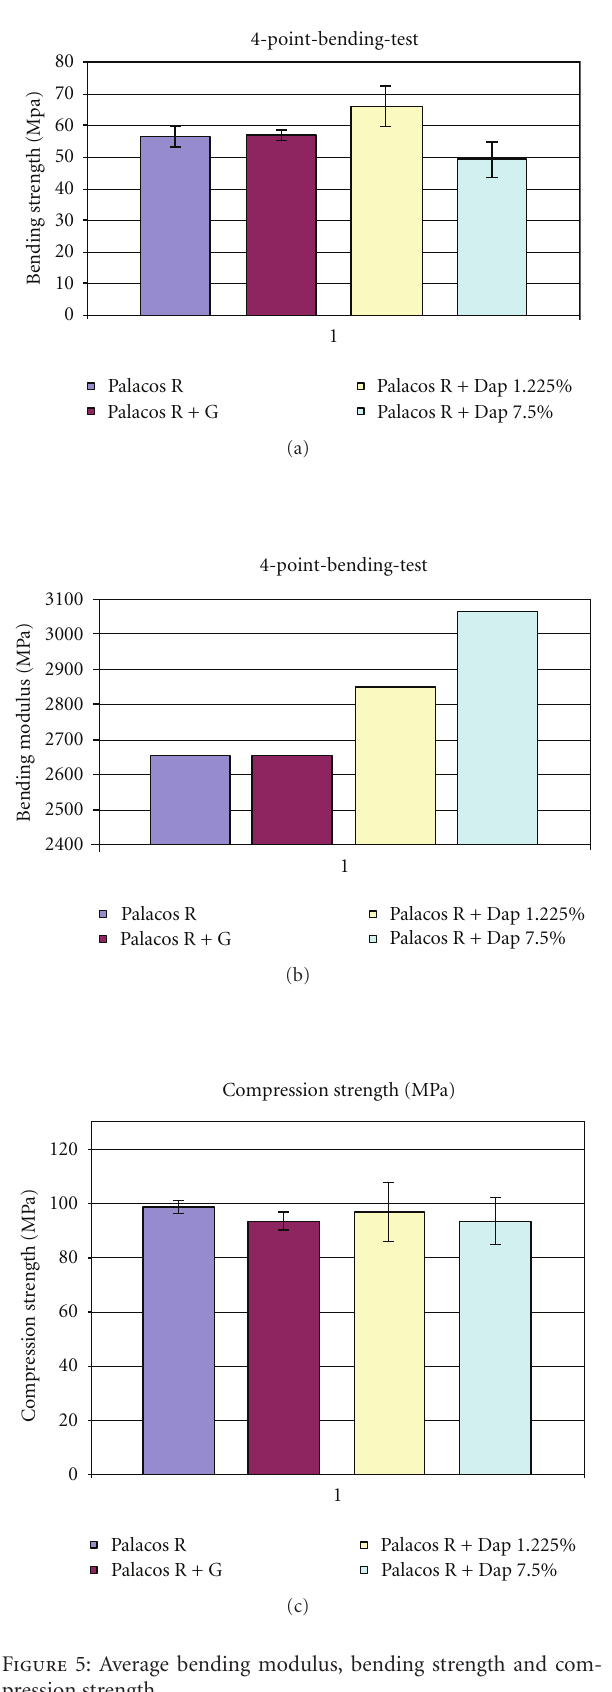
Figure 5: Average bending modulus, bending strength and com- pression strength.